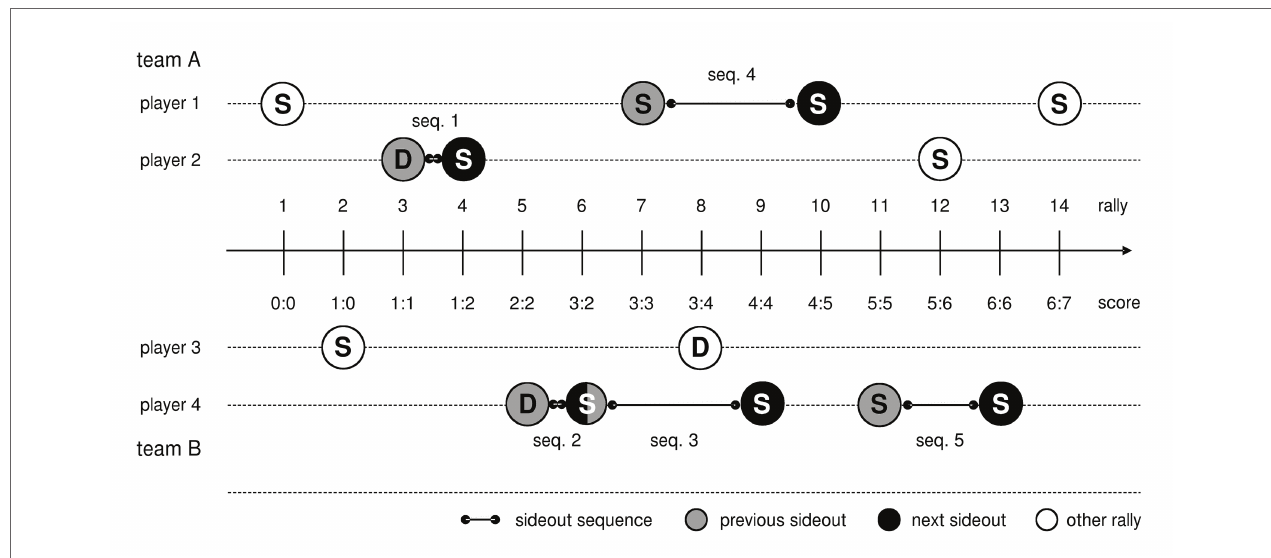
FIGURE 1 | Concept of sideout sequences. Example showing all five sideout sequences (seq.) during the first 14 rallies (circles) in a match. Capital letters indicate whether the sideout team (S) or the serving/defending (D) team scored. In rally 3, the sideout is played by player 2, the serving team scored, and player 2 received the next service in rally 4. Therefore, sequence 1 consists of the previous sideout 3 and next sideout 4. Sequence 4 aggregates the previous sideout in rally 3 and the next sideout in rally 10 by player 1. Rallies 8 and 9 do not interrupt sequence 4 because the length of the time window is three rallies only. One sideout can also be part of two sequences. For example, sideout in rally 6 is the next sideout in sequence 2 as well as the previous sideout in sequence 3. Sideouts in rallies 1 and 3 are not a sequence because they were played by different players. Sideouts in rallies 10 and 14 are also not a sequence, although they were played by the same player. The reason is that the time window between them is more than three rallies. The same applies to the pairs 1/7, 2/8, and